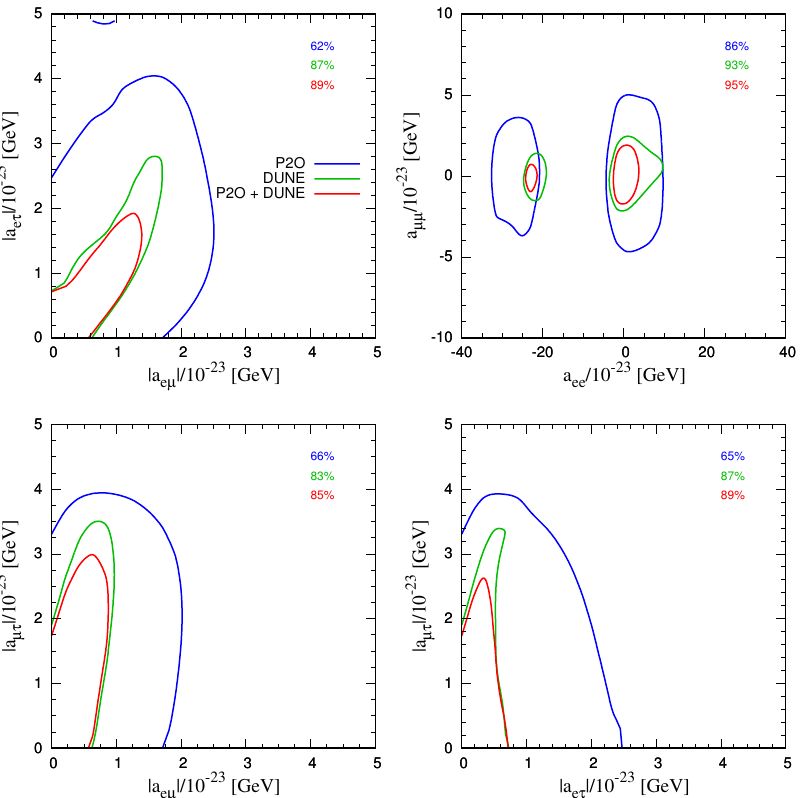
Figure 6 . Similar to figure 5 but shows the exclusion regions in the parameter spaces with both off-diagonal LIV parameters (top-left, bottom-left and bottom-right panels) and both diagonal LIV parameters (top right